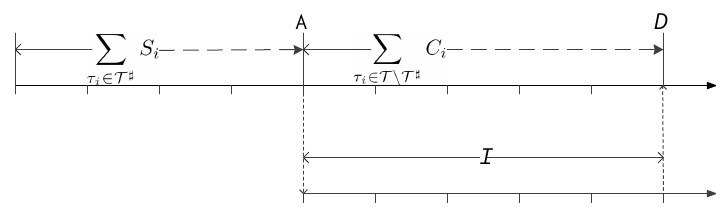
Figure 5 Illustration for the NP -completeness proof of the SERTO